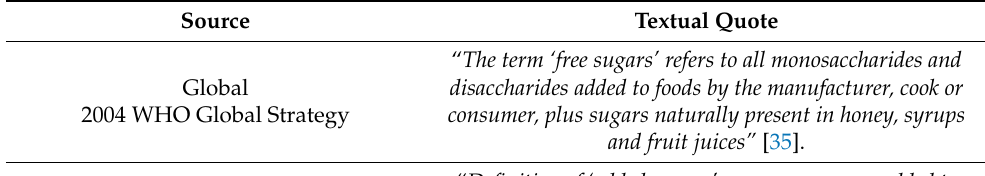
Table 4. Textual comparison of the definition of